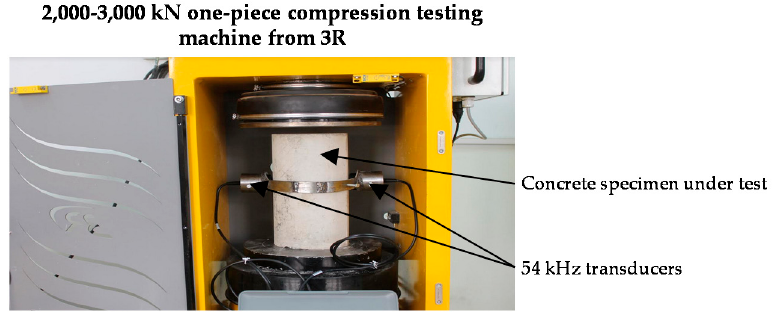
Figure 5. Ultrasonic NDT during compression of a concrete specimen.